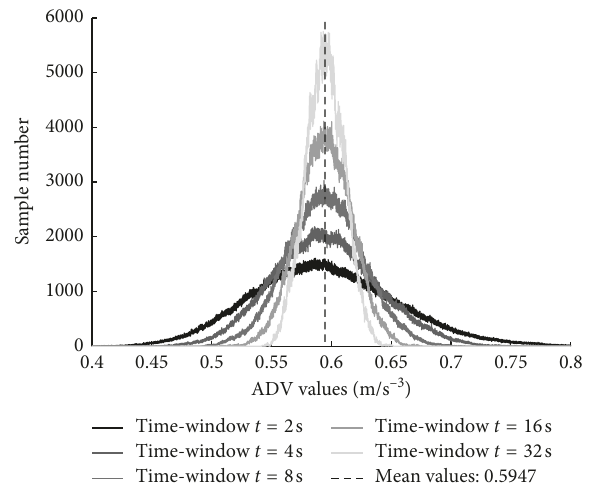
Figure 5: Statistics of ADV values calculated at different time- window.